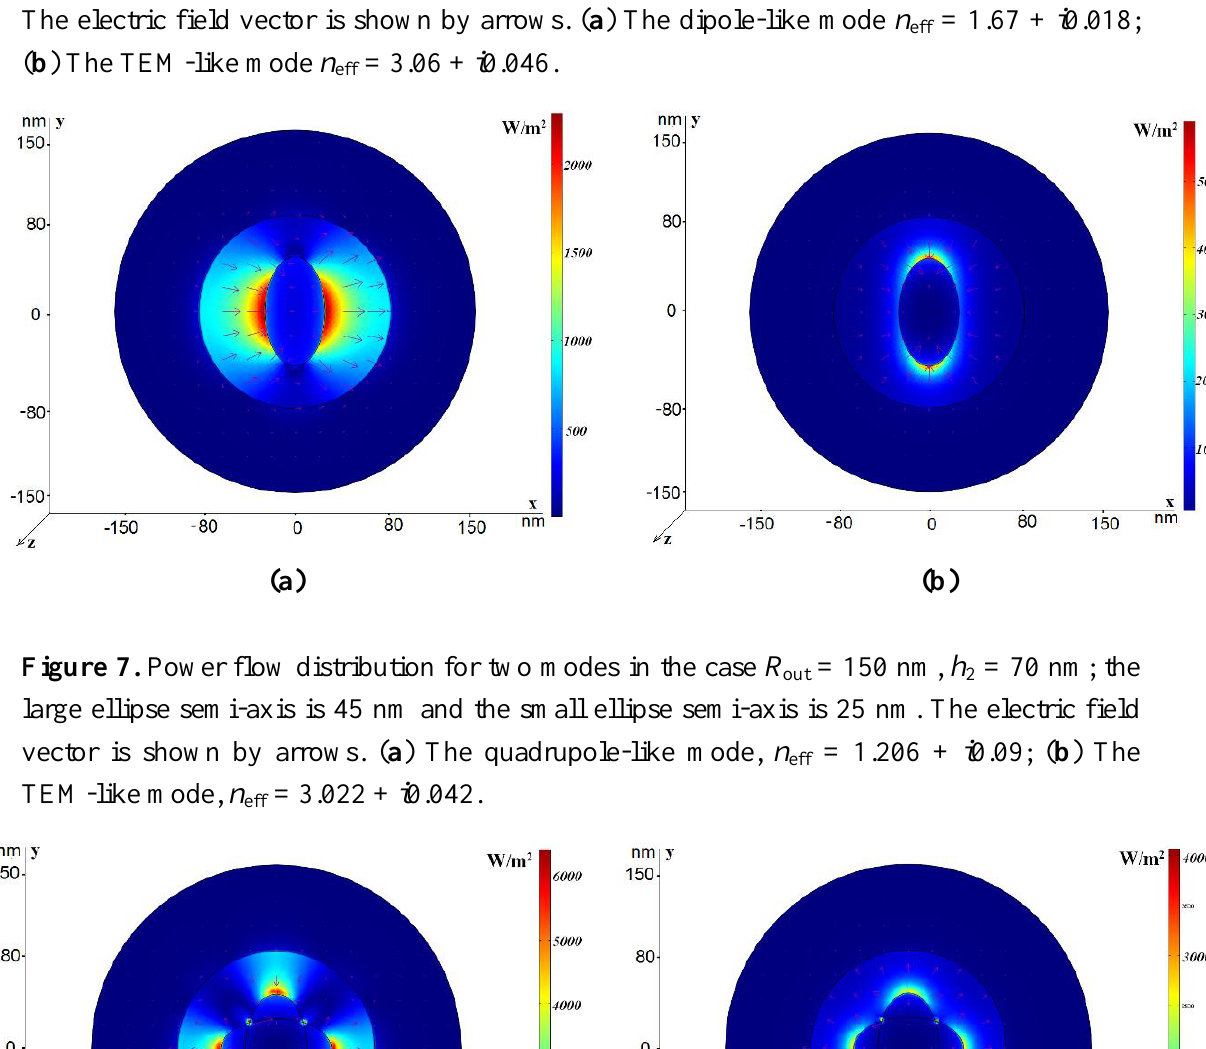
= 150 nm, out = 1.67 + i 0.018; eff